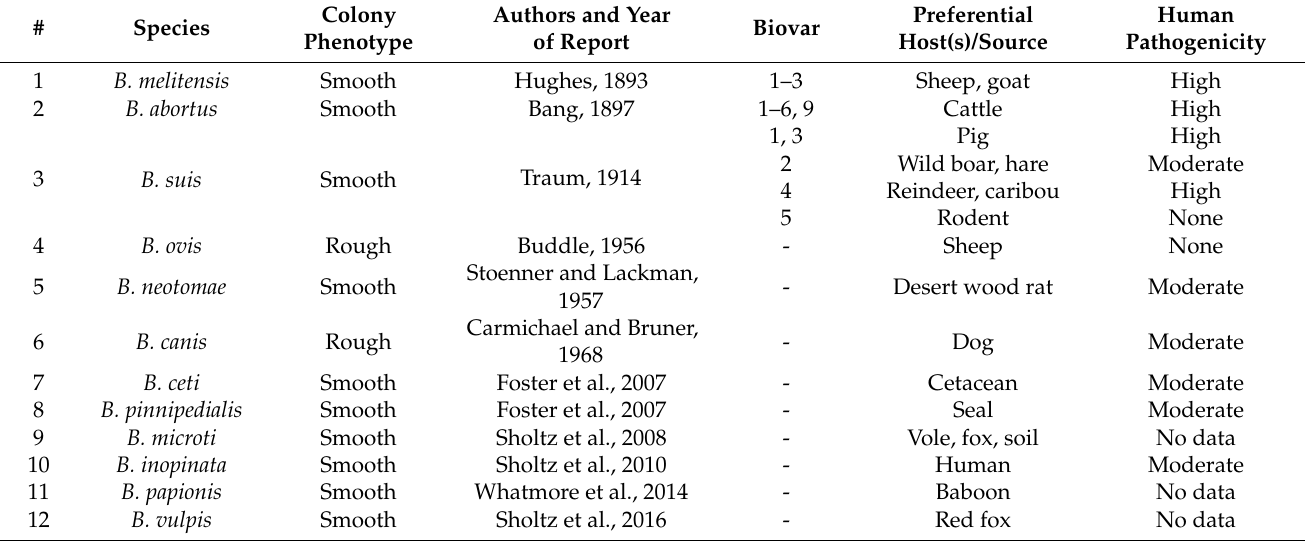
Table 1. The currently known Brucella